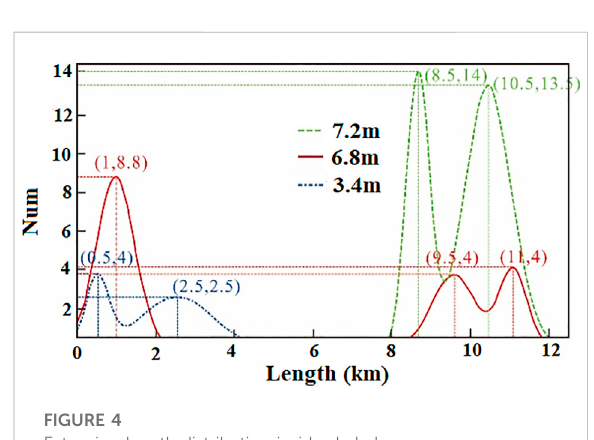
FIGURE 4 Extension length distribution inside shale